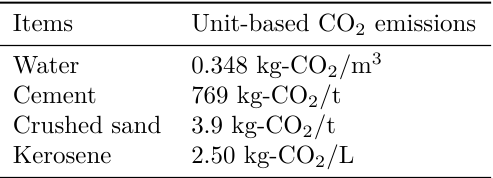
Table 3. CO 2 emission